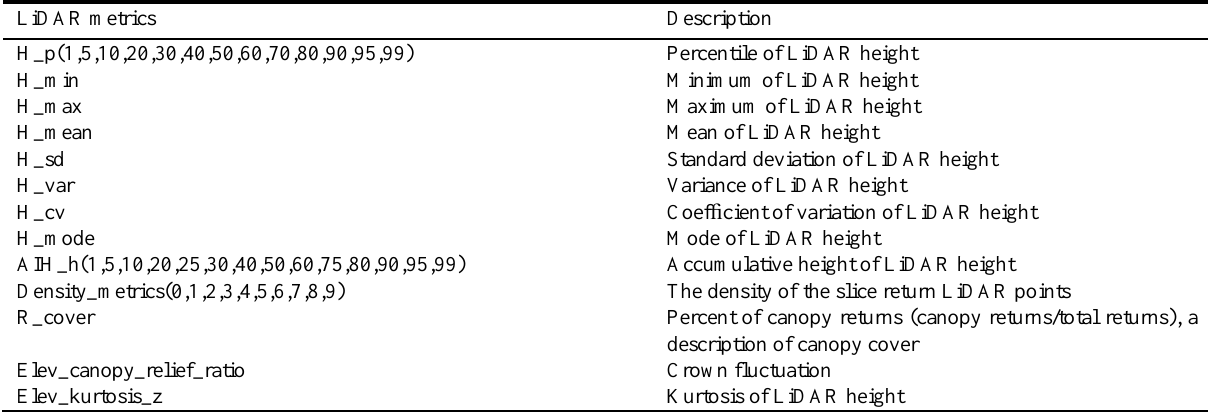
Table 1. Summary of the feature metrics derived from the LiDAR data used as candidate variables for estimating biomass leading to a pulse density of approximately 2 pts/m4.54 .